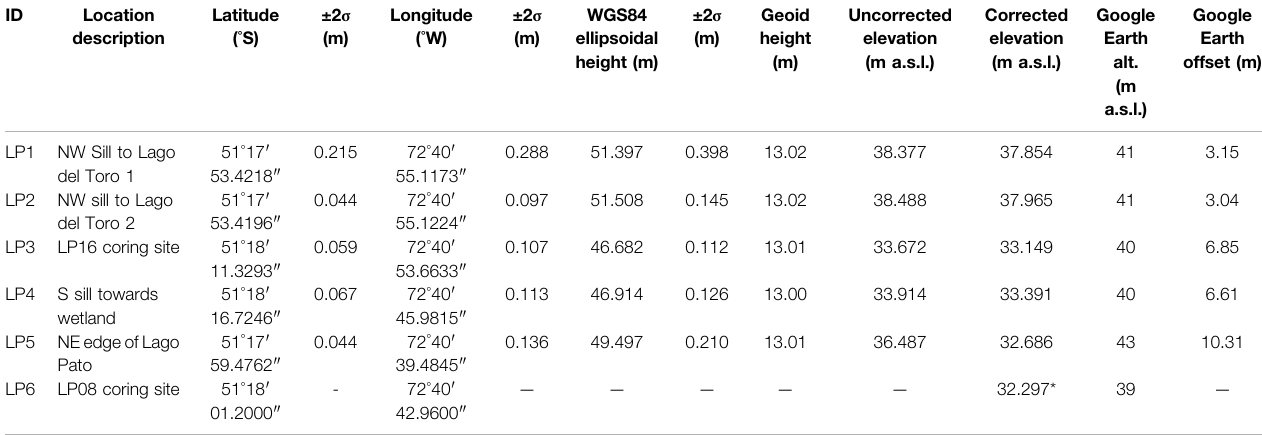
TABLE1| GeomorphologicaldatacollectedfromLagoPato.DatamarkedwithanasteriskwerecalculatedbysubtractingthemeanGoogleEarthoffset(6.70±5.95 m)from GPS measured data. Field measurements were undertaken using a Trimble 5700 GPS in December 2015, with a tripod height correction of 0.523 m using WGS84 as the reference ellipsoid, corrected using the EGM96 geoid model. Calculated elevations are shown to three decimal places, but the actual precision is, at best, one decimal place. ID Location